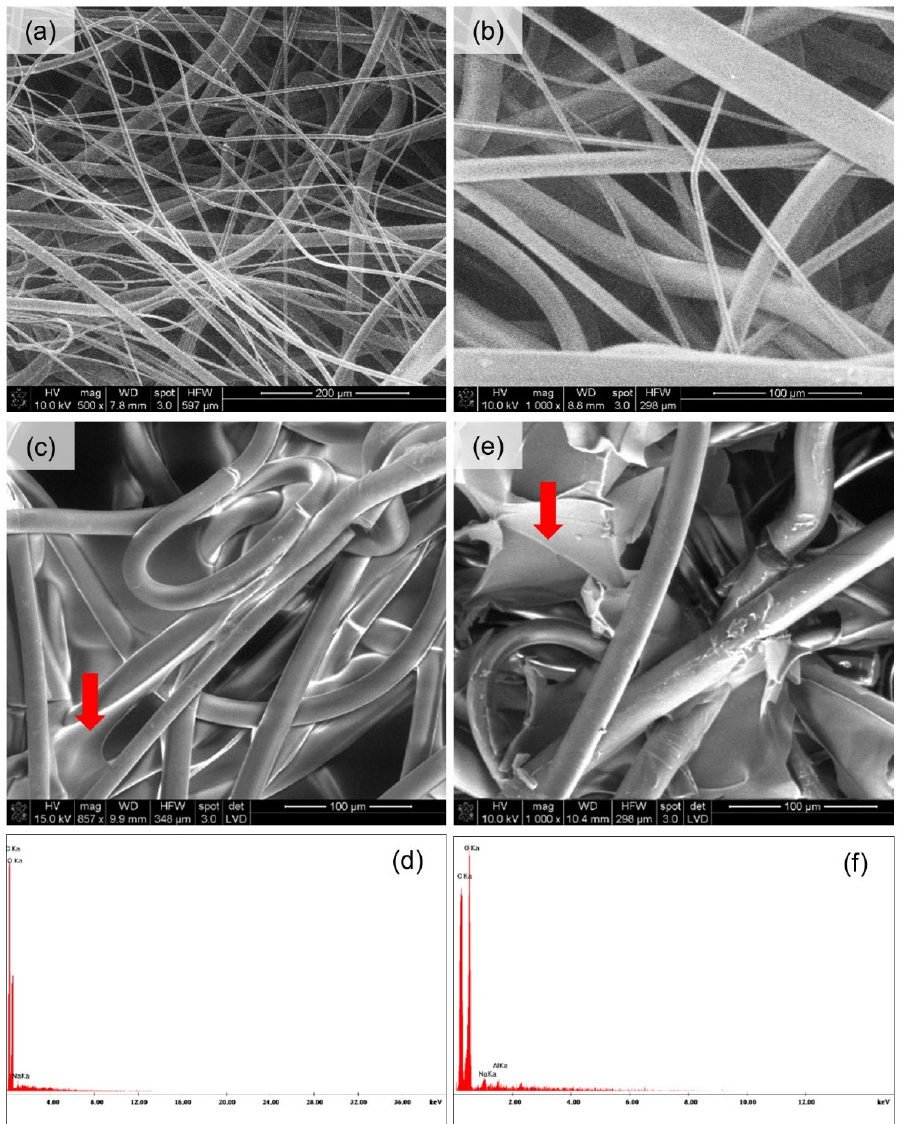
Figure 13. SEM and EDX images of the melt-blown PLA nonwoven fabrics: ( a , b ) reference sample— melt-blown PLA nonwoven without deposit; ( c , d ) sample with sodium alginate deposition (3 min, 35 V, T = 25 °C); ( e , f ) sample with sodium hyaluronate deposition (3 min, 35 V, T = 25 °C).